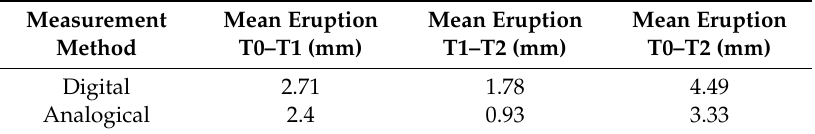
Table 2. Mean values of canine’s eruption calculated in T0–T1 (corresponding to eruption from initial situation to 2 months), in T1–T2 (from 2 to 4 months), and the total eruption movement T0–T2 with digital and analogical methods.